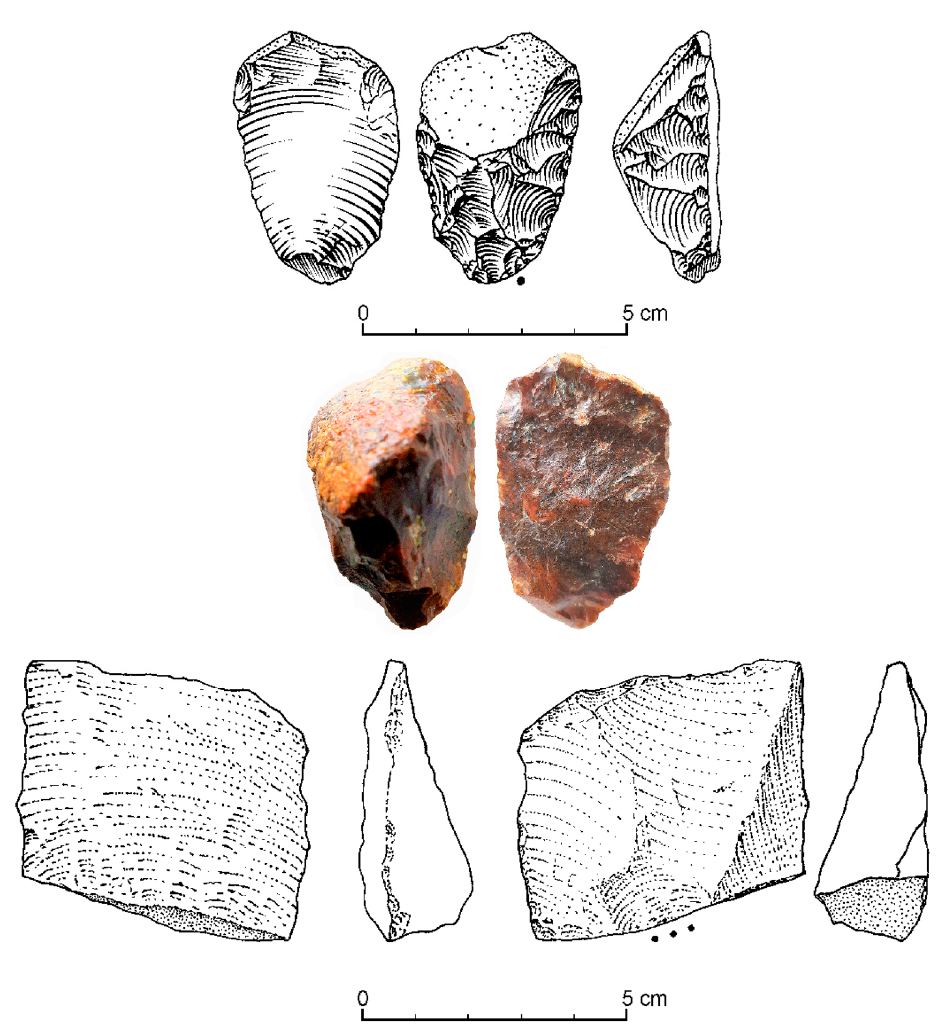
Figure 4. Münster-Sarmsheim. In situ finds from the 200 m tNa 5.1-2 terrace: double-side scrapper (agate) and a quartzite flake from a core with opposite striking platforms. The three dots symbolize three identifiable impact points. (Photo: S. Stoll, drawing: L. Fiedler).